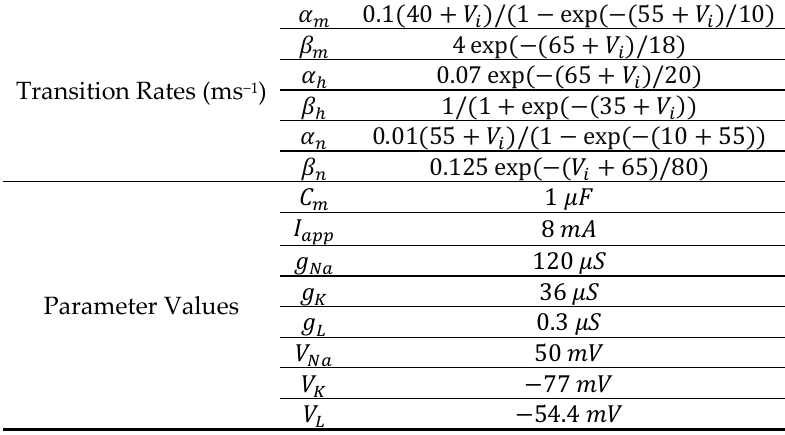
Table 1. Transition rates and parameter values for the HH